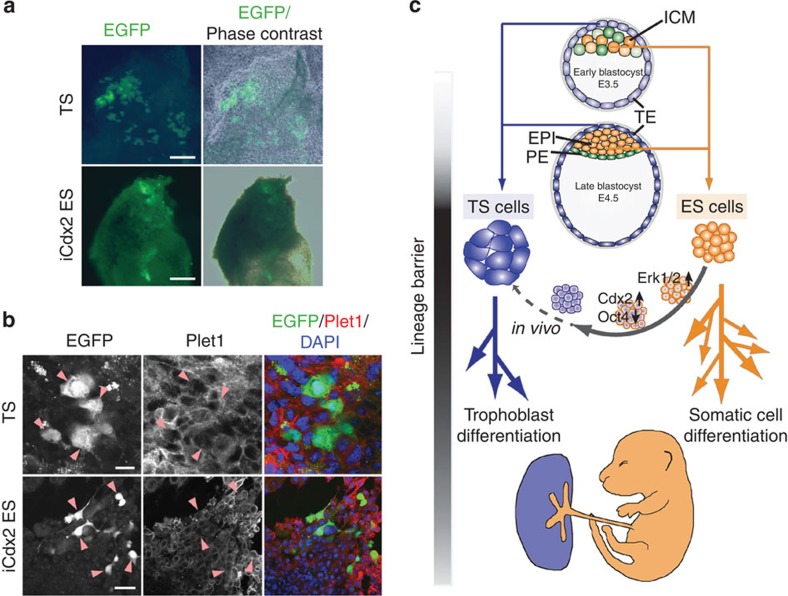
Chimerization potential of TSL cells.(a) Example overview images of a TS cell and iCdx2 ES cell chimera. Both cell lines carry constitutively expressed EGFP transgenes for identification. Please note, for better visualization of cellular contribution, the trophoblast compartment was dissected away from the embryo and flattened under a coverslip for the TS cell chimera. Scale bars: 100 μm (TS) and 250 μm (iCdx2). (b) Confocal images of outgrowths of chimeric trophoblast tissue stained for Plet1 (and Ezrin, shown in Supplementary Fig. 7). Arrowheads highlight chimerizing, EGFP-positive cells that are seemingly fully integrated into the tissue context and express Plet1 in a pattern indistinguishable from surrounding nonchimeric trophoblast cells. Scale bars: 20 μm (TS) and 50 μm (iCdx2). (c) Model of the profound divergence between the first two cell lineages in development and its epigenetic reinforcement that underpins the resistance to reprogramming in ES-to-TS cell conversion approaches. Some progression of reprogramming may occur in the niche environment in vivo, but on the whole ES-to-TS cell reprogramming remains incomplete in vitro and cells retain a reduced chimerization potential even in vivo. EPI, epiblast; ICM, inner cell mass; PE, primitive endoderm; TE, trophectoderm.